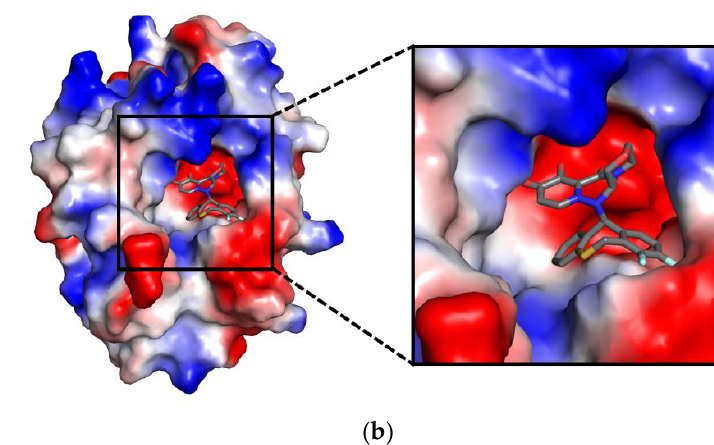
Figure 5. Structure of the approved cap-dependent endonuclease inhibitor baloxavir marboxil. ( a ) Chemical structure of the prodrug baloxavir marboxil. ( b ) Crystal structure of baloxavir (shown as sticks with grey carbon atoms, oxygen in red, nitrogen in blue, and fluorine in cyan) in the binding cleft of endonuclease. The surface of the endonuclease was colored according to is calculated negative ( − 69 kT/e, red) and positive (+69 kT/e, blue) electrostatic potential. The structure was determined by X-ray crystallography (10.2210/pdb6FS6/pdb) [40]. The figure was generated with PyMOL